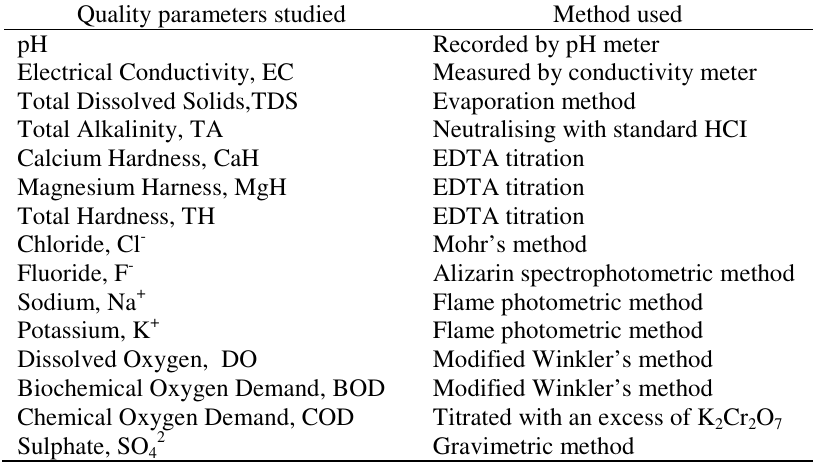
Table 2. Methods used for analysis of quality parameters for water